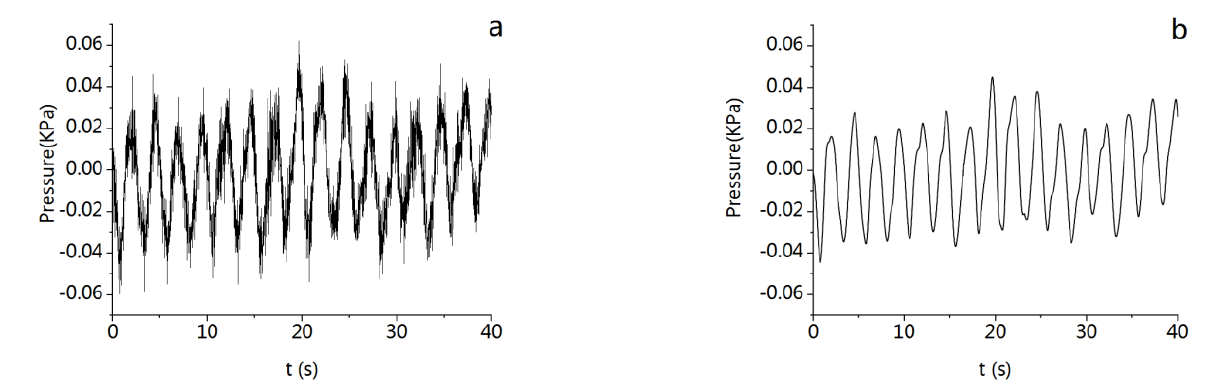
Figure 4. Effect of wavelet denoising: ( a ) Original pressure signal with noise; ( b ) Denoised pressure signal.